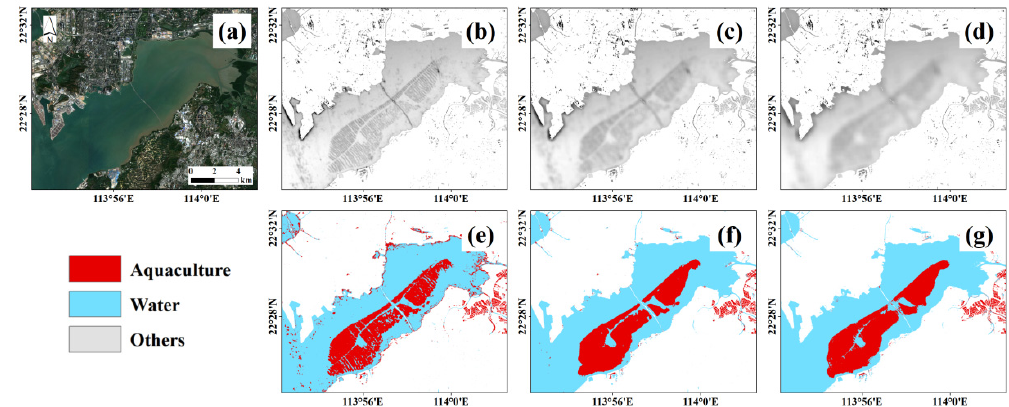
Figure 10. Maximum sum average texture of VH using different window sizes and the aquaculture maps: ( a ) Sentinel-2A false color images, ( b – d ) image features with a window size of 5 × 5 pixels, 15 × 15 pixels and 30 × 30 pixels, and ( e – g ) aquaculture maps.